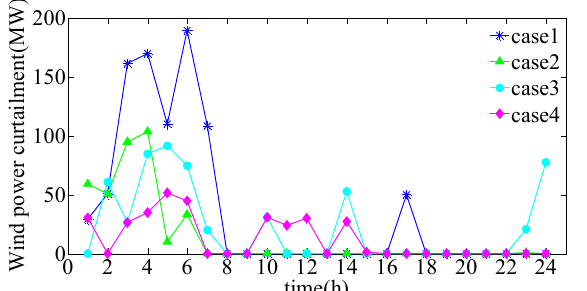
Figure 6. Hourly wind power curtailment. In the figure, the blue curve drawn by asterisk connection, the green curve drawn by triangle connection, the cyan curve drawn by circular connection and the purple curve drawn by diamond connection, respectively, represent the wind power curtailment of Case 1, Case 2, Case 3 and Case 4.